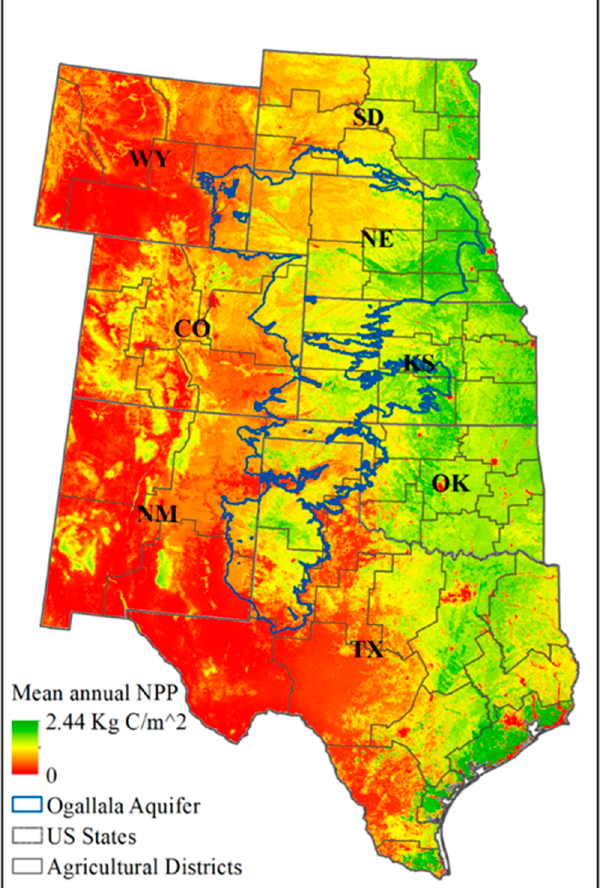
Figure 3. Mean annual net primary production (NPP) for the period 2001 to 2018. Data obtained from [35].